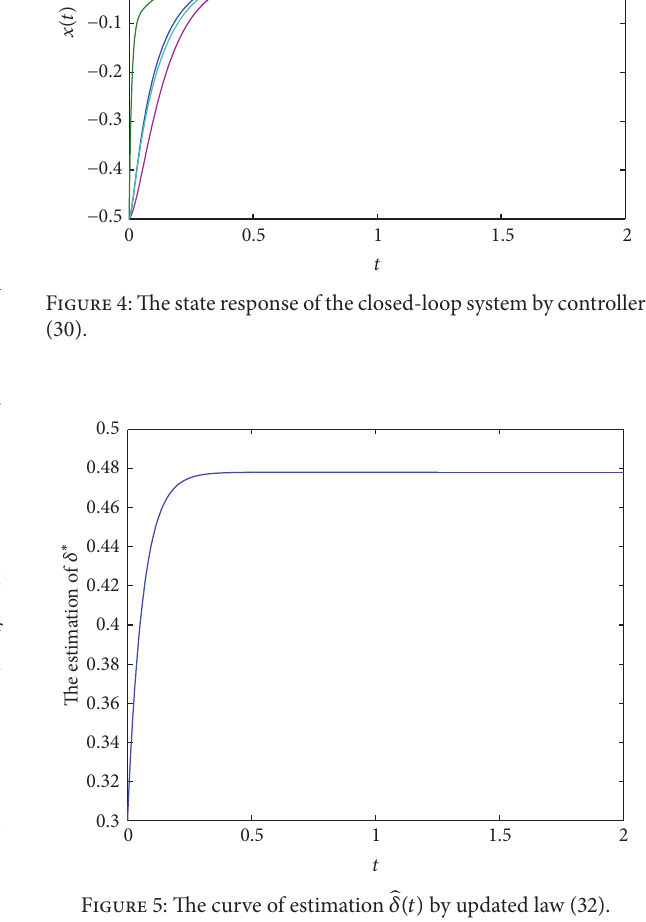
Figure 5: The curve of estimation